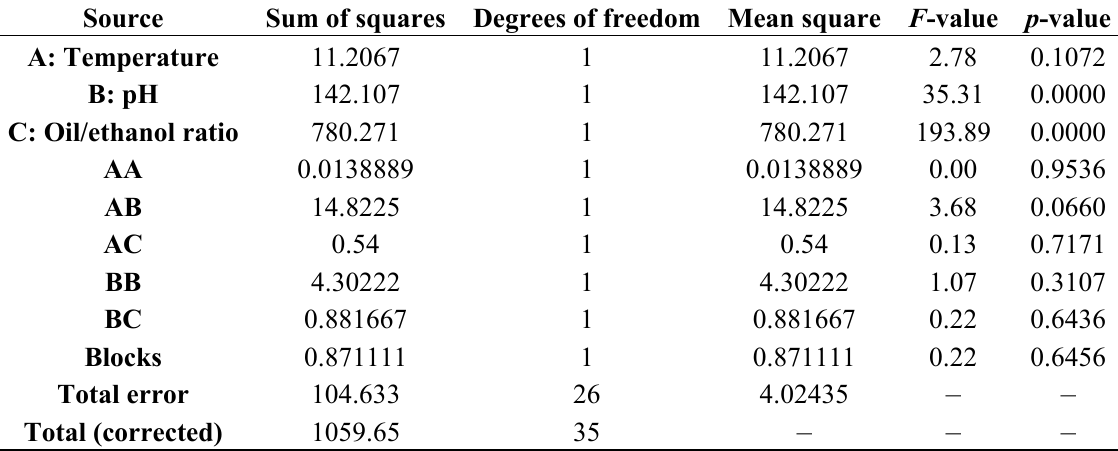
Table 4. Analysis of variance (ANOVA) for